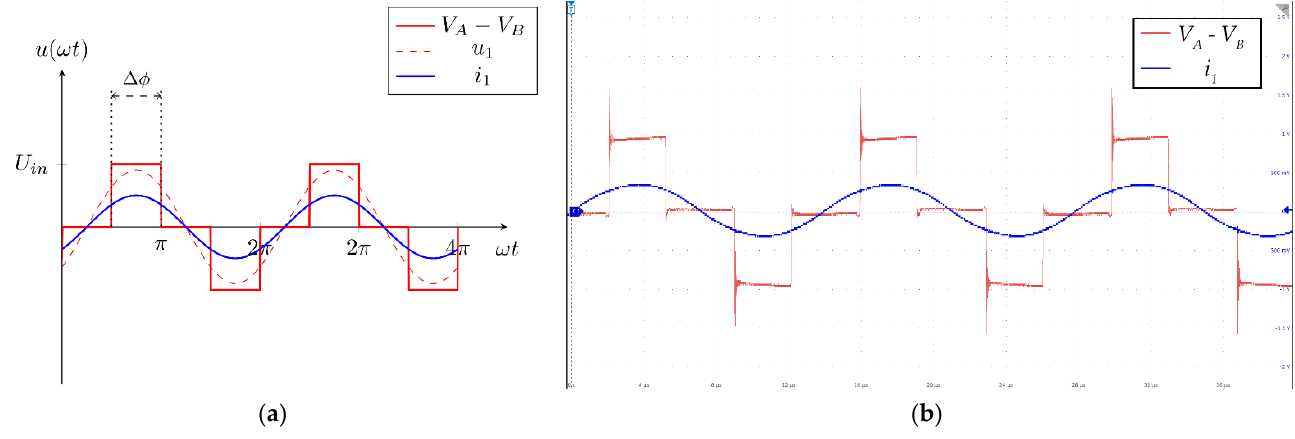
Figure 2. Voltage and current waveforms at the input of the resonant circuit: ( a ) theoretical waveforms; ( b ) waveforms measured on the experimental system.